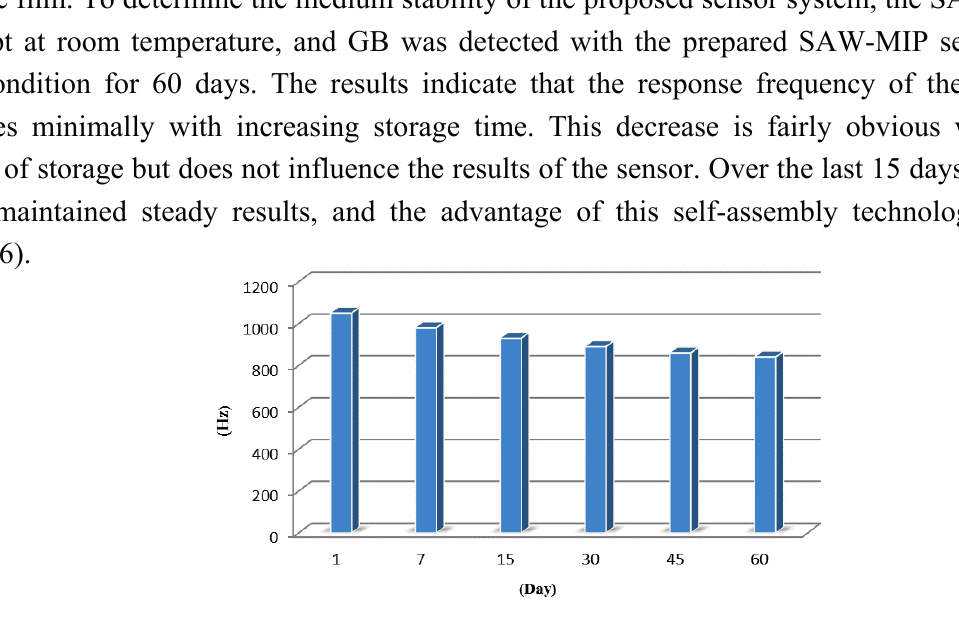
Figure 6. Stability of the sensor after storage for several